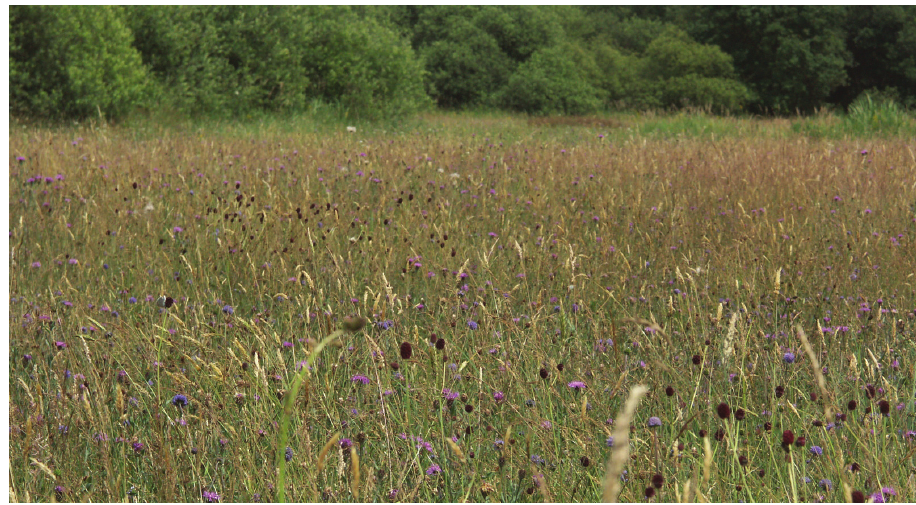
Red List Status Europe: Vulnerable EU: Vulnerable Conservation Status in EU in 2007 (Article 17 assessment) Alpine region: bad Atlantic region: bad Boreal region: favourable Continental region: bad Pannonian region: inadequate Threats in